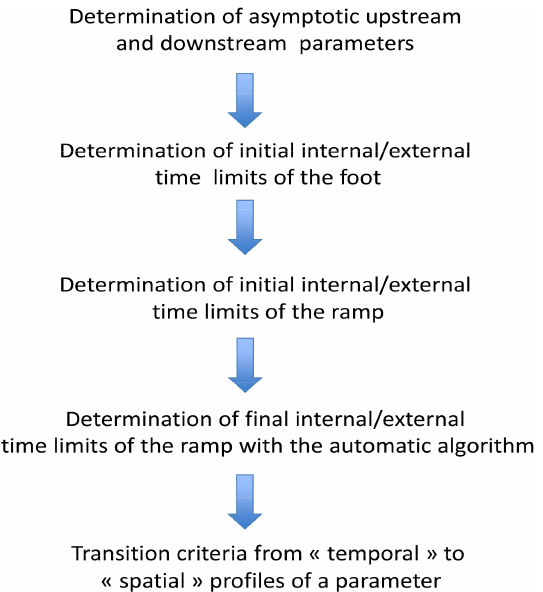
Figure 2. Different stages of the methodology (see text for